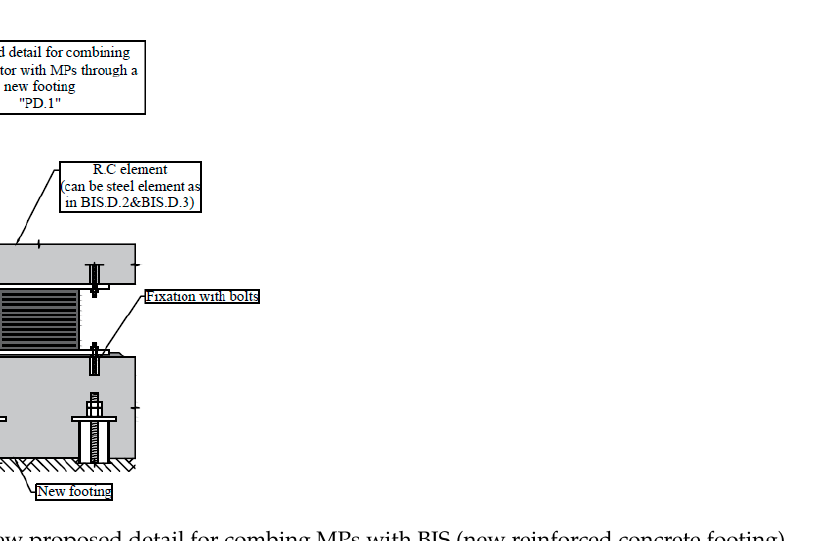
Figure 13. MP connection to a new/existing steel base frame—typical detail (after [1]).